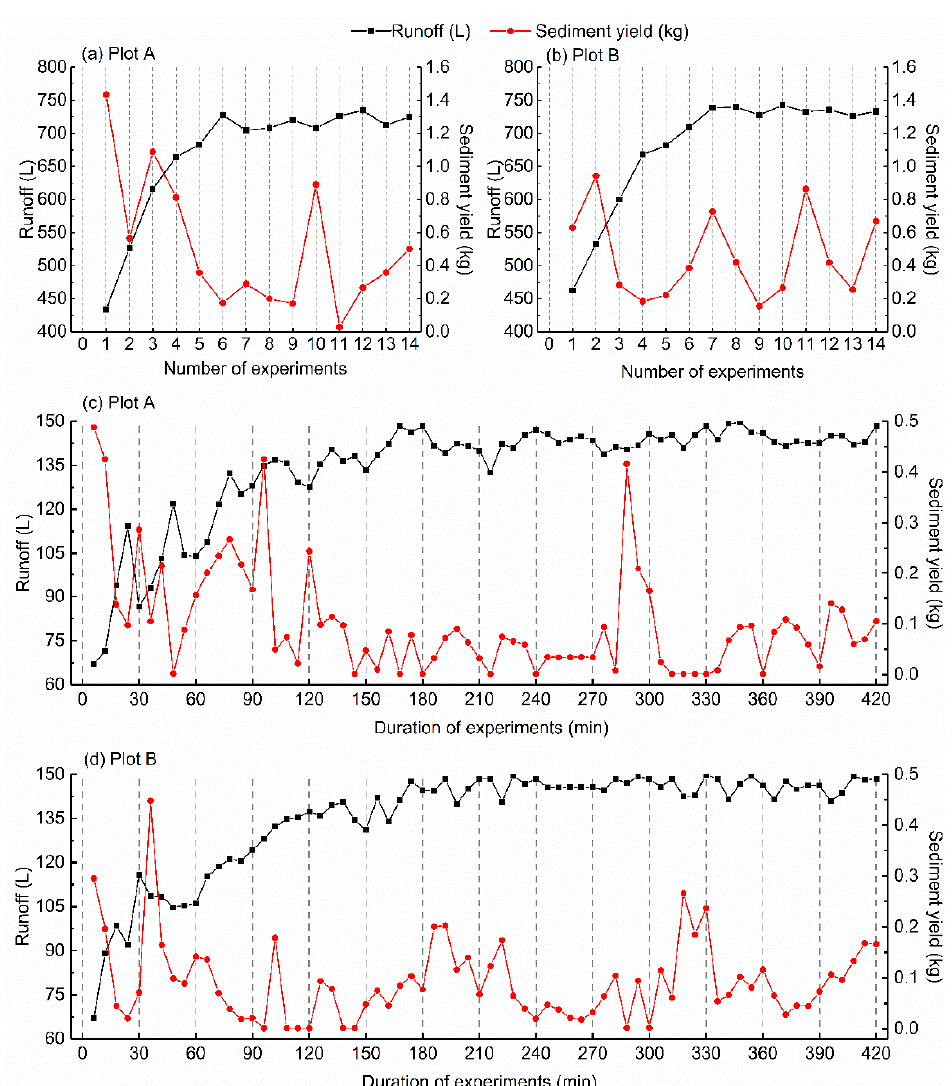
Figure 5. Runoff and sediment yield from hillslopes of plots A and B: ( a , b ) inter-experiment; ( c , d ) intra-experiment.